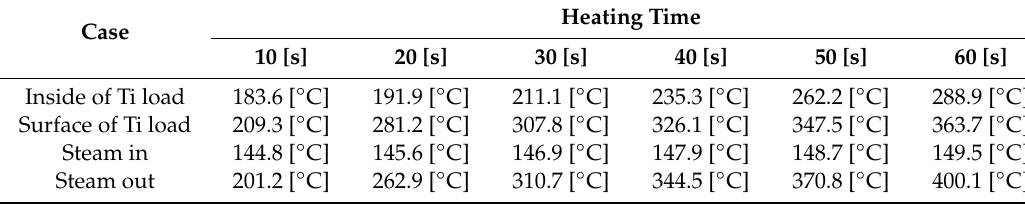
Figure 18. Temperature graph of the steam heating test. Table 4. Temperature results of the steam heating test.